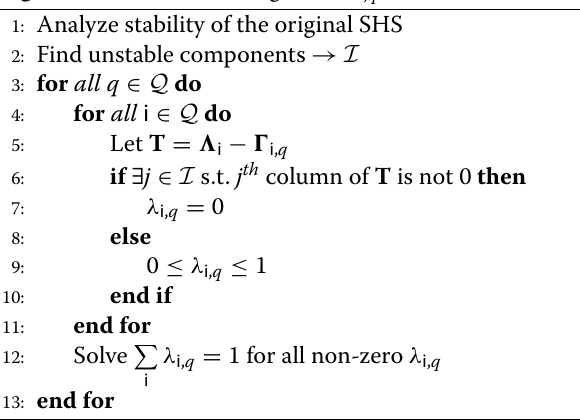
Algorithm 2 Find stable region of λ i ,